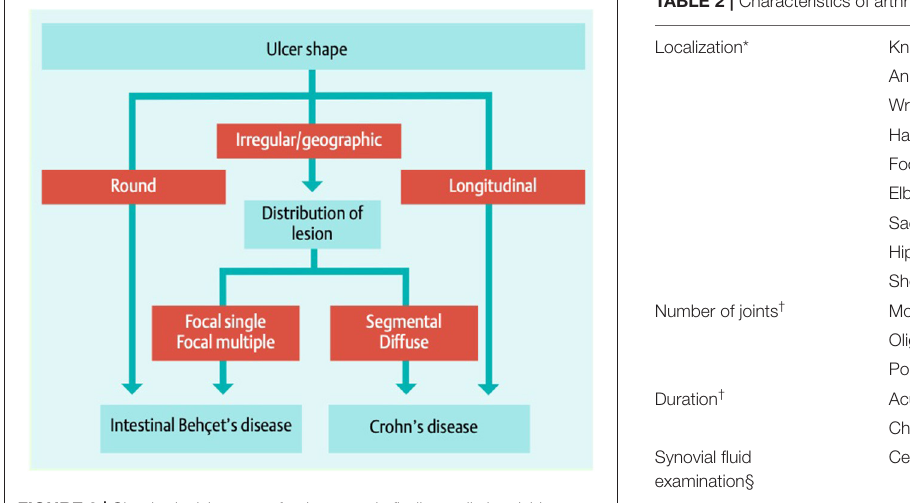
FIGURE 3 | Simple decision tree of colonoscopic findings, distinguishing GIBD from CD Lee et al. ( 71). With permission of the author and the publisher.